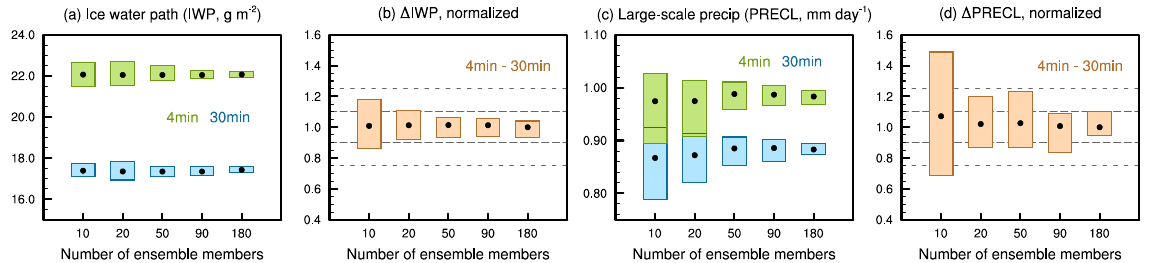
Figure 5. Impact of ensemble size on the estimated (a) global mean ice water path, (c) global mean large-scale precipitation rate, and (b, d) their sensitivity to model time step. In panels (a) and (c) , blue and green correspond to simulations performed with 30 min and 4 min time steps, respectively. The dots inside filled boxes are ensemble mean values averaged over the entire integration period (20 days). Top and bottom of the boxes denote the maximum and minimum daily averages. Similarly, the 4 min/30 min differences are shown in panels (b) and (d) , except that all values are normalized by the 20 day average of the 180-member ensemble mean, in order to show the relative differences among the estimates associated with different ensemble sizes. Further details are explained in Sect. 3.3.